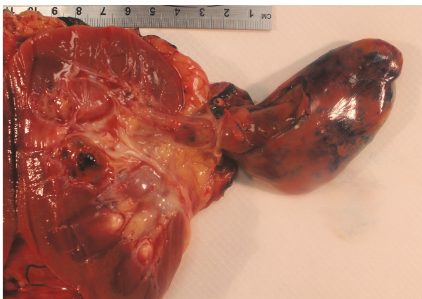
Figure 2: Gross image of the intrarenal mass and an elongated pedicle extending into the lumen of the inferior vena cava. The mass is lobulated and partially cystic and the pedicle has a smooth border.